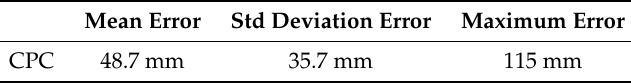
Table 5. Positioning errors using the 4